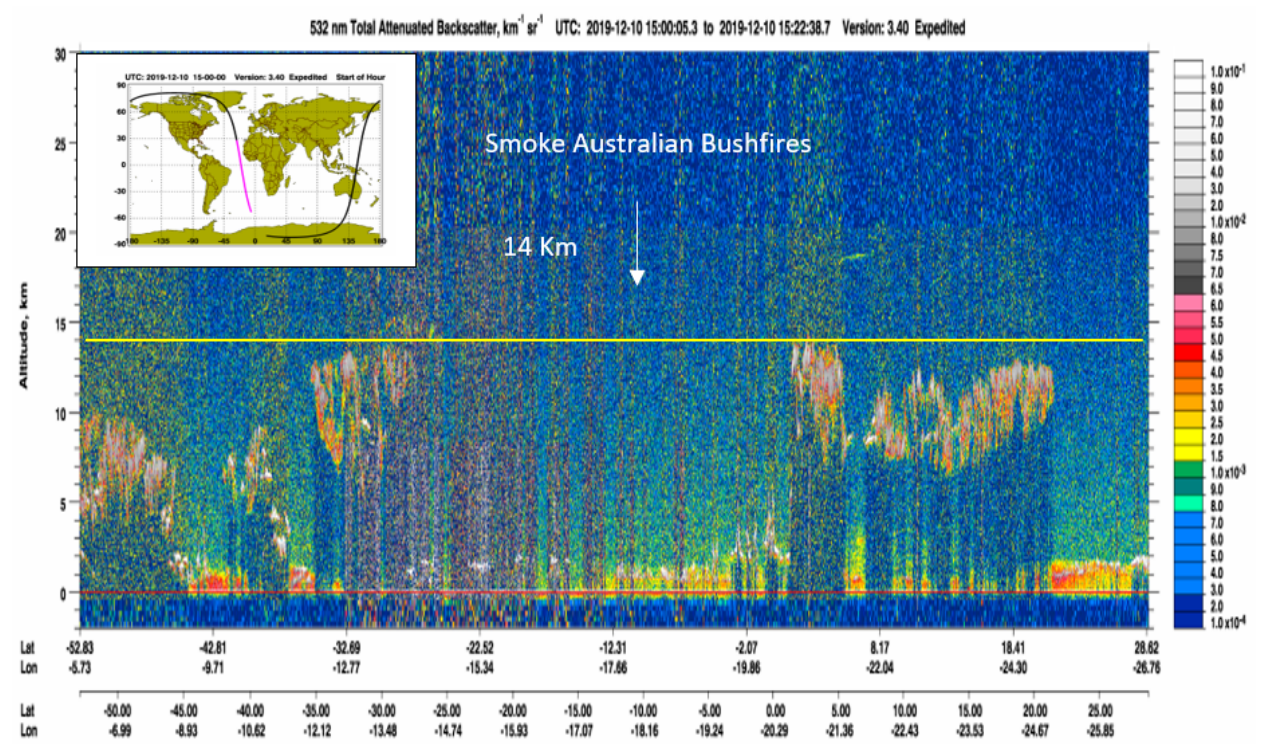
( b ) Figure 9. Elevated aerosol values (red) are indicated by the aerosol optical depth (AOD) from the ( a ) Aqua and ( b ) Terra sensors on the MODIS satellite. Sites of high bushfire activity (red dots) on 10 December 2019 are also indicated. ( https://worldview.earthdata.nasa.gov (accessed on 20 January 2020)). The 24 h backward trajectories from HYSPLIT, using the GDAS global data, were started from Sydney at 00:00 UTC (11:00 EST) on 10 December 2019 when the highest hourly concentrations of PM 10 occurred within the Sydney region (Figure 3a). The HYSPLIT backward pathways were calculated for 100 m, 500 m and 2000 m above ground